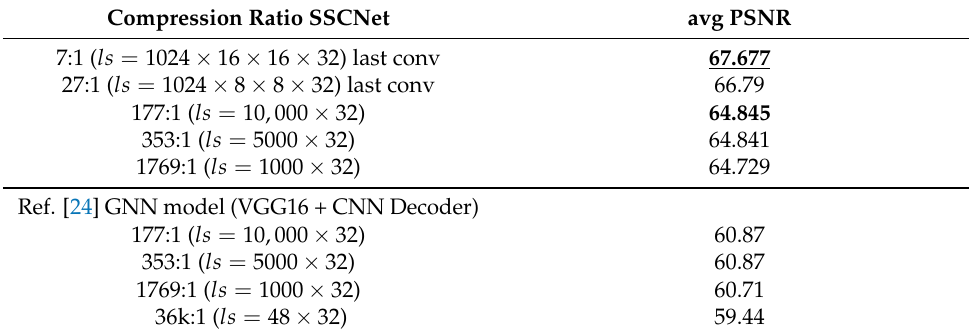
Table 5. Compression ratio achieved by SSCNet using different latent space output (ls) or with the last convolution version. We report the PSNR between the original spectral source and the output of SSCNet (PSNR is averaged over all bands of the VIRTIS-Rosetta dataset). We report the results of GNN model based-on VGG16.